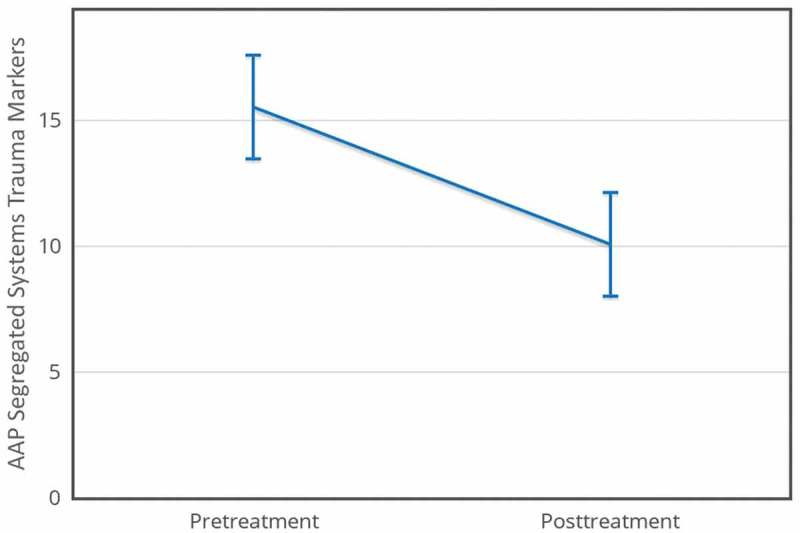
AAP Segregated Systems Trauma Markers, N = 15.